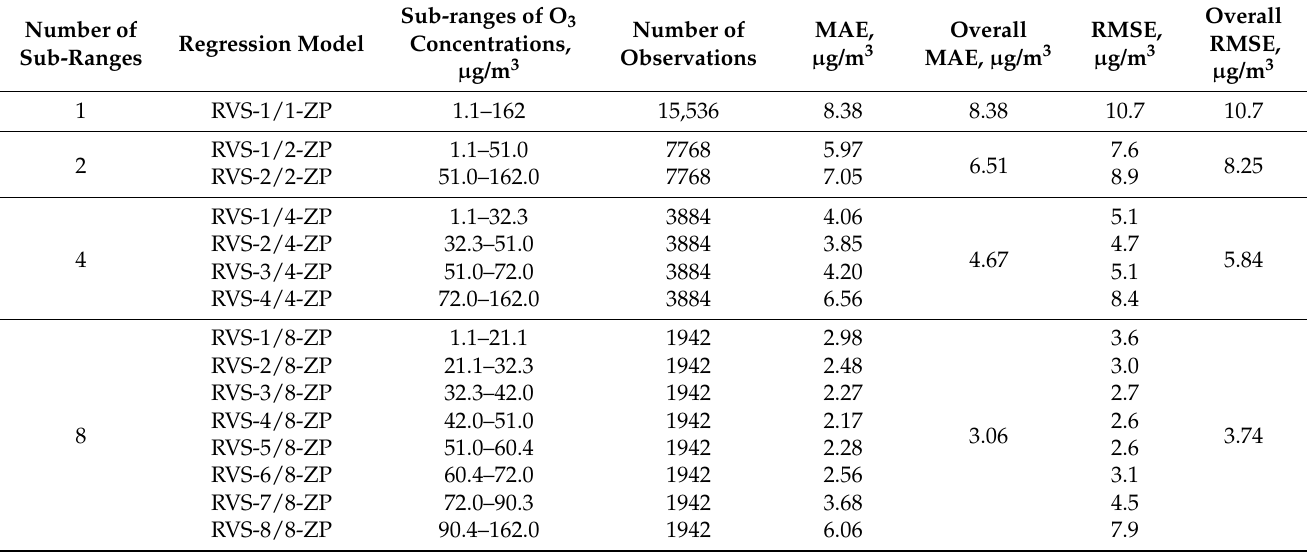
Table 6. Values of approximation errors of O 3 concentrations in RVS models, Złoty Potok